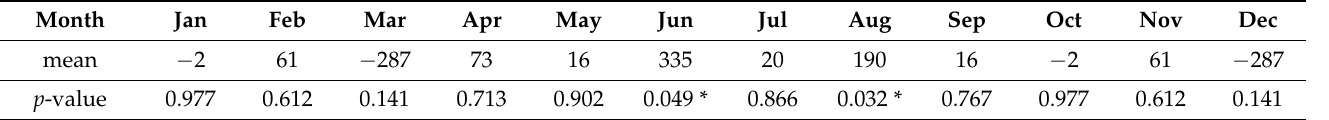
Table 3. Paired sample t -test for months of 2016 and